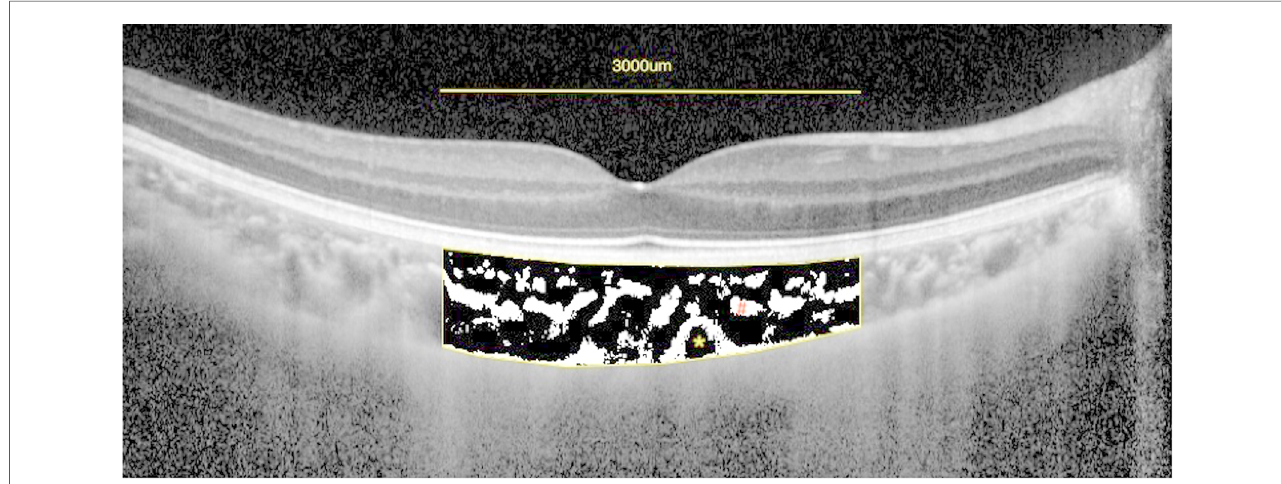
FIGURE 2 Enhanced depth imaging (EDI)-OCT image and converted binary image of a normal eye. An EDI-OCT image of a healthy eye ( A ) was converted to a binary image ( B ) using the ImageJ software. The luminal area (dark area, asterisk) and the interstitial area (cross) are seen. The rectangle surrounded by a red line was excised, and the dark areas were traced by the Niblack method.